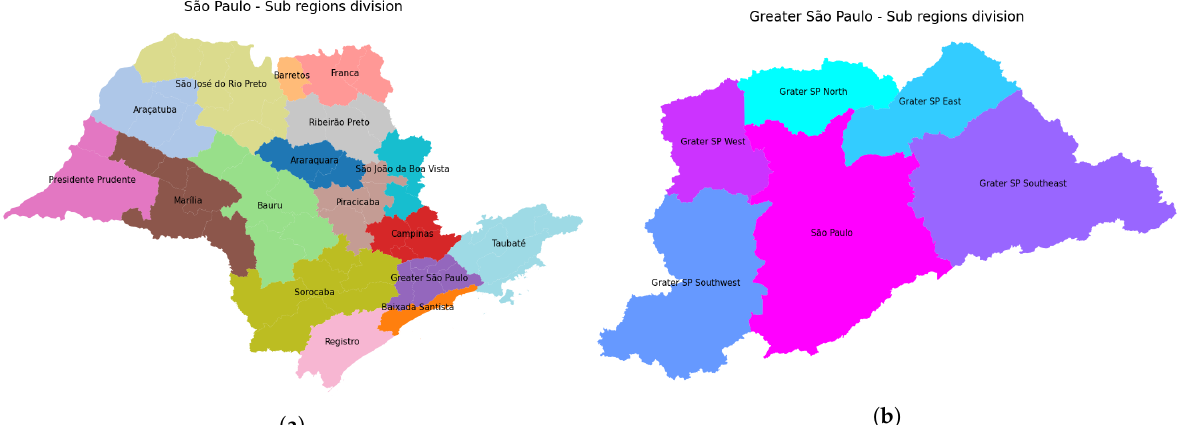
Figure 5. Sub-region maps of São Paulo state: ( a ) State map showing the 22 state sub-regions, and ( b ) São Paulo metropolitan